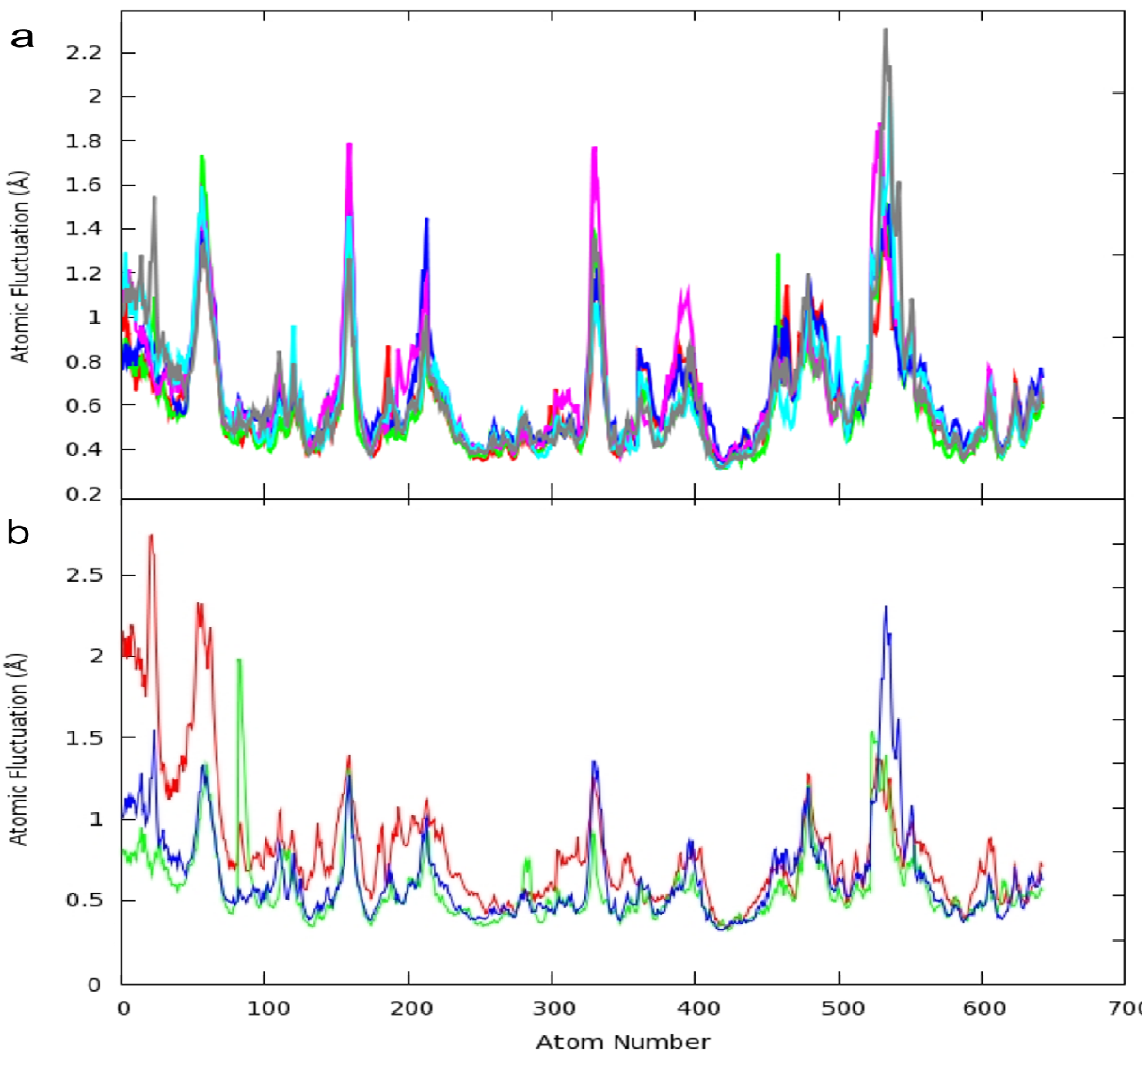
Figure 5. ( a ) Atomic fluctuations (Å) in the core of 642 atoms during the final 3.5 ns of the 6 CDK5 MD simulations. Graph shows the atomic fluctuations (Å) of the C, C atoms in the backbone during the last 3.5 ns of the MD simulations for: CDK5 D144N /p25 bound with aloisine-A (magenta), indirubin-3'-oxime (red), R -roscovitine (green) and ATP (blue); apo CDK5 D144N /p25 (grey) and apo CDK5/p25 (cyan); ( b ) Atomic fluctuations (Å) in the mask of 642 atoms during the final 3.5 ns of the GSK3 β (green), ERK2 (red) and CDK5/p25 (blue) MD